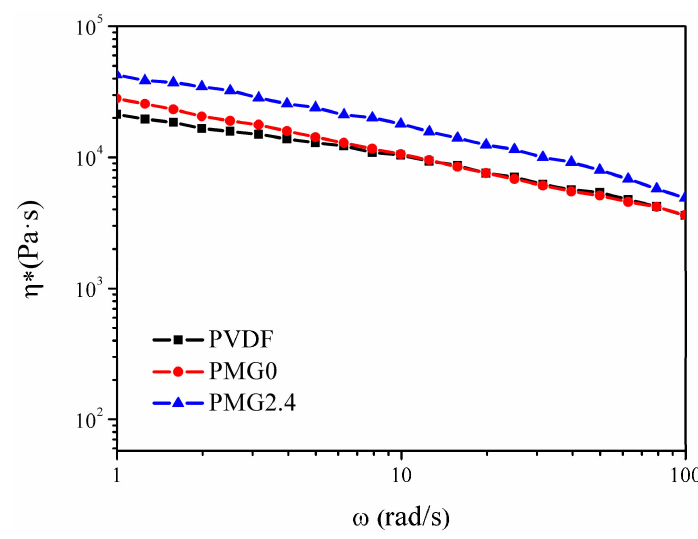
Figure 6. Complex viscosity ( η *) versus frequency for the neat PVDF, PMG0 and c-MWCNTs/MG/PVDF with 2.4 vol %